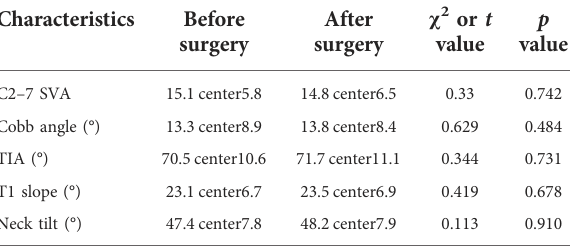
TABLE 6 Radiographic measurement of all the patients pre- and postoperatively at the sagittal plane.